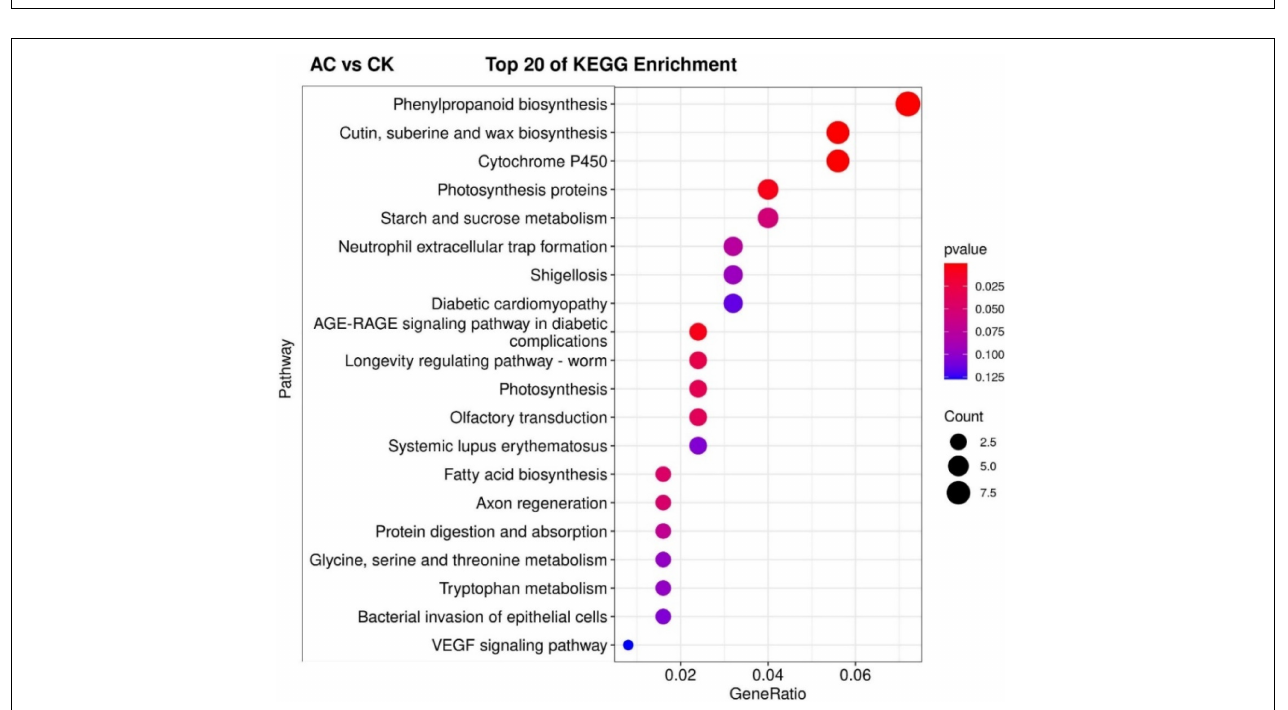
FIGURE 6 | The top 20 of the Kyoto Encyclopedia of Genes and Genomes (KEGG) pathway enrichment of DEGs between the AC and CK. The first 20 pathways with the smallest P- values were used to draw the map, with pathway as the ordinate and enrichment factors as the abscissa (the number of differences in this pathway divided by all the numbers). The size of the circle indicated the number. The redder the color was, the smaller the P -value was, and the pathway representing the redder bubbles had more DEGs.